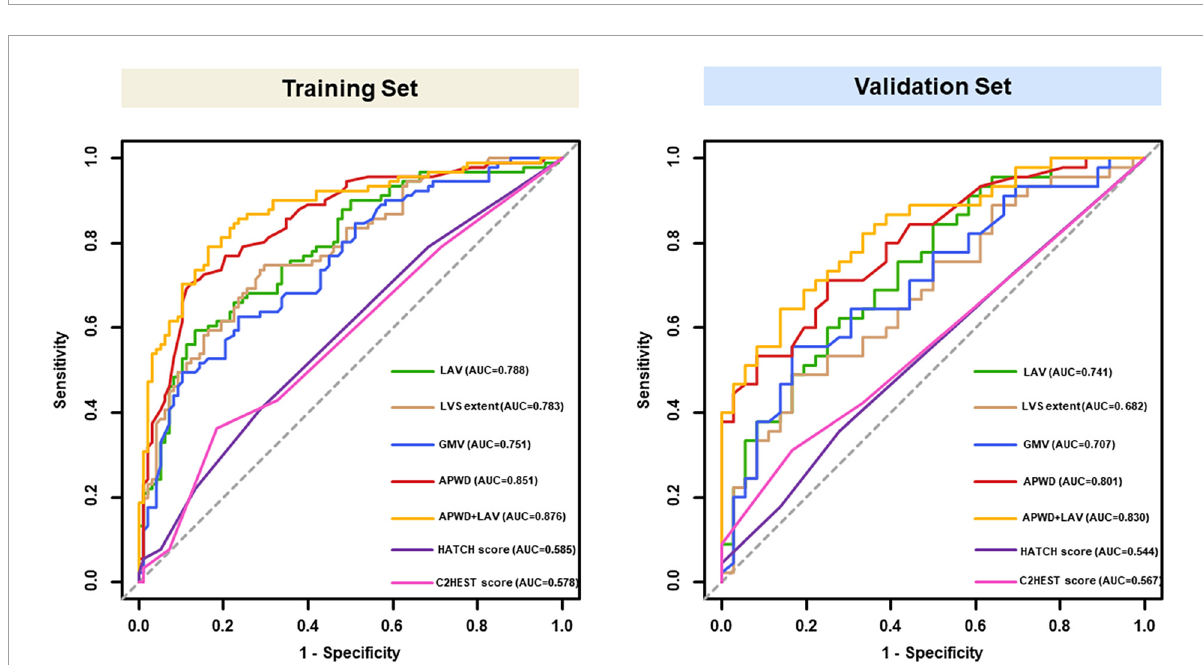
FIGURE4 ROC curves of models for identification of AF persistency in training (left) and validation set (right) . Results of LAV (green), LVS extent (brown), GMV (blue) and APWD (red) represent the discriminative performance in single-dimension. The integrated (bi-dimensional) model (APWD + LAV) is illustrated in yellow curve. The HATCH score and C2HEST score were presented in purple and pink curves, respectively. ROC, receiver operating characteristics; AUC, area under the curve; LAV, left atrial volume; LVS, low voltage substrate; GMV, global mean voltage; APWD, duration of the amplified digital